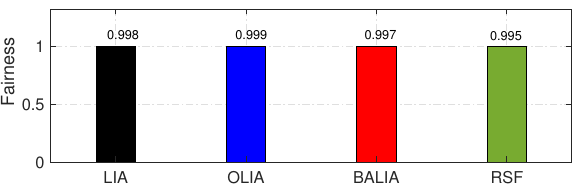
Figure 4. Fairness results for 4 MB files in Scenario 2: homogeneous paths with 10 Mbps bandwidth, 150 ms delay, and 2% random packet